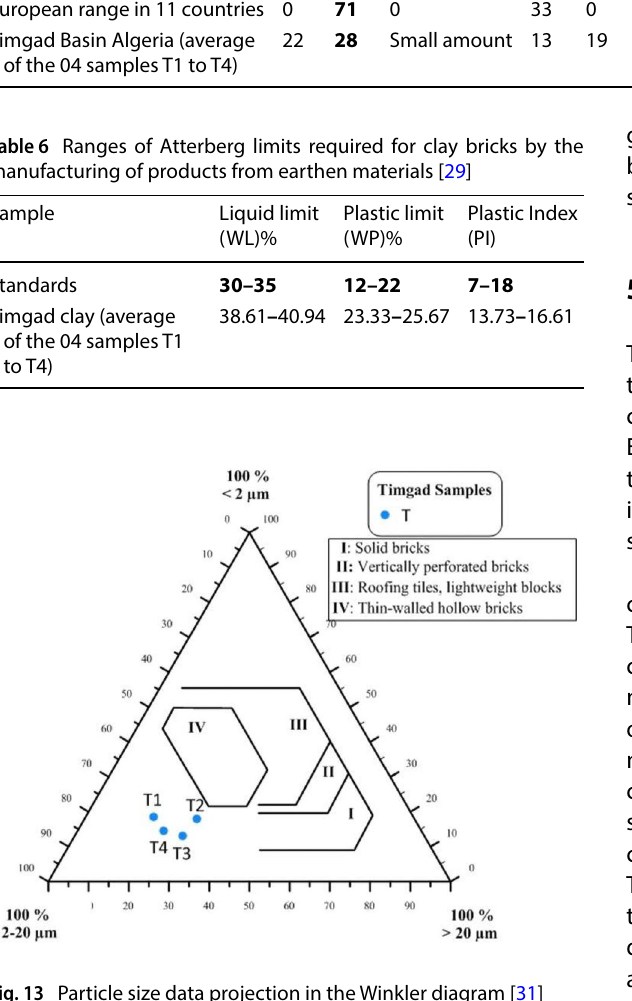
Timgad Basin Algeria (average of the 04 samples T1 to T4)